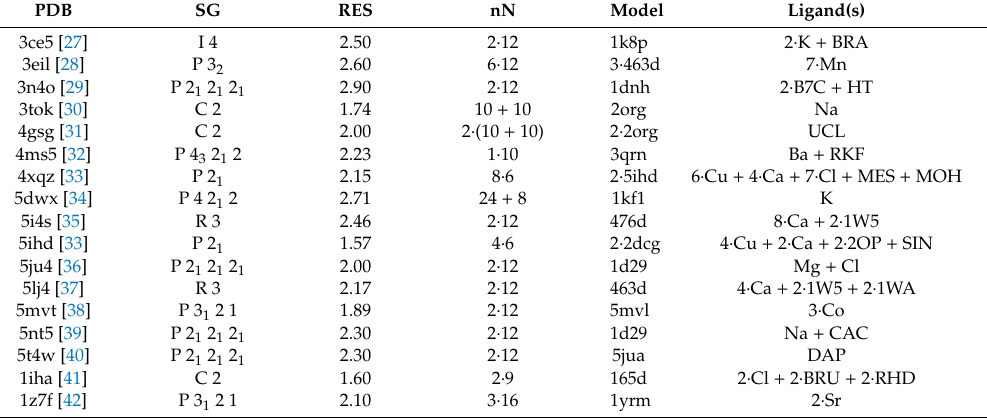
Table 1. For the 29 nucleic acid test structures, the following abbreviations are used: Protein Data Bank (PDB) for the structure code, space group (SG) and the di ff raction data resolution (RES) (Å). The number of nucleotides in the asymmetric unit (nN) is reported by the symbol n · N, where n is the number of chains per asymmetric unit, N is the number of nucleotides per chain. N is replaced by a sum of two numbers if chains with di ff erent type or di ff erent number of nucleotides are present. The model used in the MR step (column model) is reported as p · CODE, where CODE is the PDB code of the molecular fragment and p is the number of fragments originally used in the MR process. The information on the ligands is given in the corresponding column, in the form of m · CODE, where CODE is the PDB code of a ligand, and m is the number of ligands in the asymmetric unit of the target structure. The chemical formula for each ligand CODE is also specified at the bottom of the Table, from which the presence of heavy atoms may be